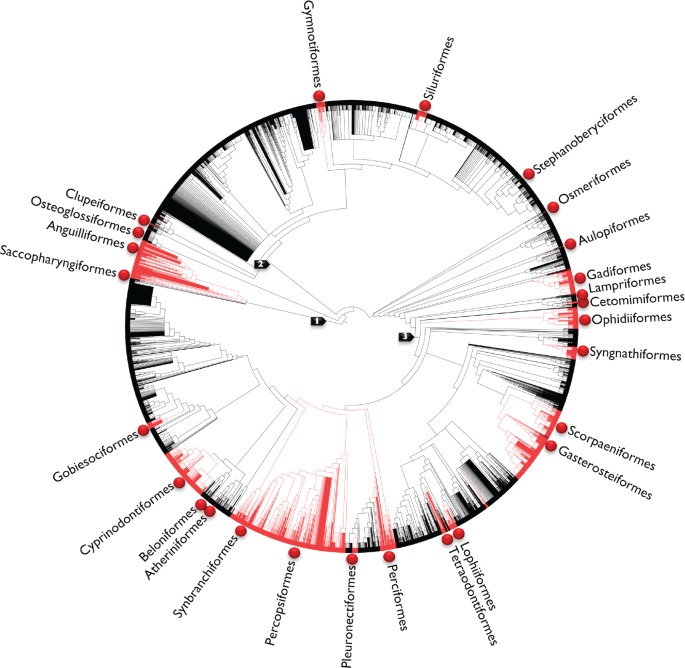
Visualization of pelvic fin presence (black) and absence (red) across 38,419 species of teleost fishes using an unordered parsimony method of reconstruction requiring 80 steps. Fin loss is evident in 26 orders (red balls). Arrows indicate higher-level groupings: 1 \documentclass[12pt]{minimal}
\usepackage{amsmath}
\usepackage{wasysym}
\usepackage{amsfonts}
\usepackage{amssymb}
\usepackage{amsbsy}
\usepackage{upgreek}
\usepackage{mathrsfs}
\setlength{\oddsidemargin}{-69pt}
\begin{document}
}{}$=$\end{document} Elopomorpha; 2 \documentclass[12pt]{minimal}
\usepackage{amsmath}
\usepackage{wasysym}
\usepackage{amsfonts}
\usepackage{amssymb}
\usepackage{amsbsy}
\usepackage{upgreek}
\usepackage{mathrsfs}
\setlength{\oddsidemargin}{-69pt}
\begin{document}
}{}$=$\end{document} Otomorpha; 3 \documentclass[12pt]{minimal}
\usepackage{amsmath}
\usepackage{wasysym}
\usepackage{amsfonts}
\usepackage{amssymb}
\usepackage{amsbsy}
\usepackage{upgreek}
\usepackage{mathrsfs}
\setlength{\oddsidemargin}{-69pt}
\begin{document}
}{}$=$\end{document} Percomorphaceae.